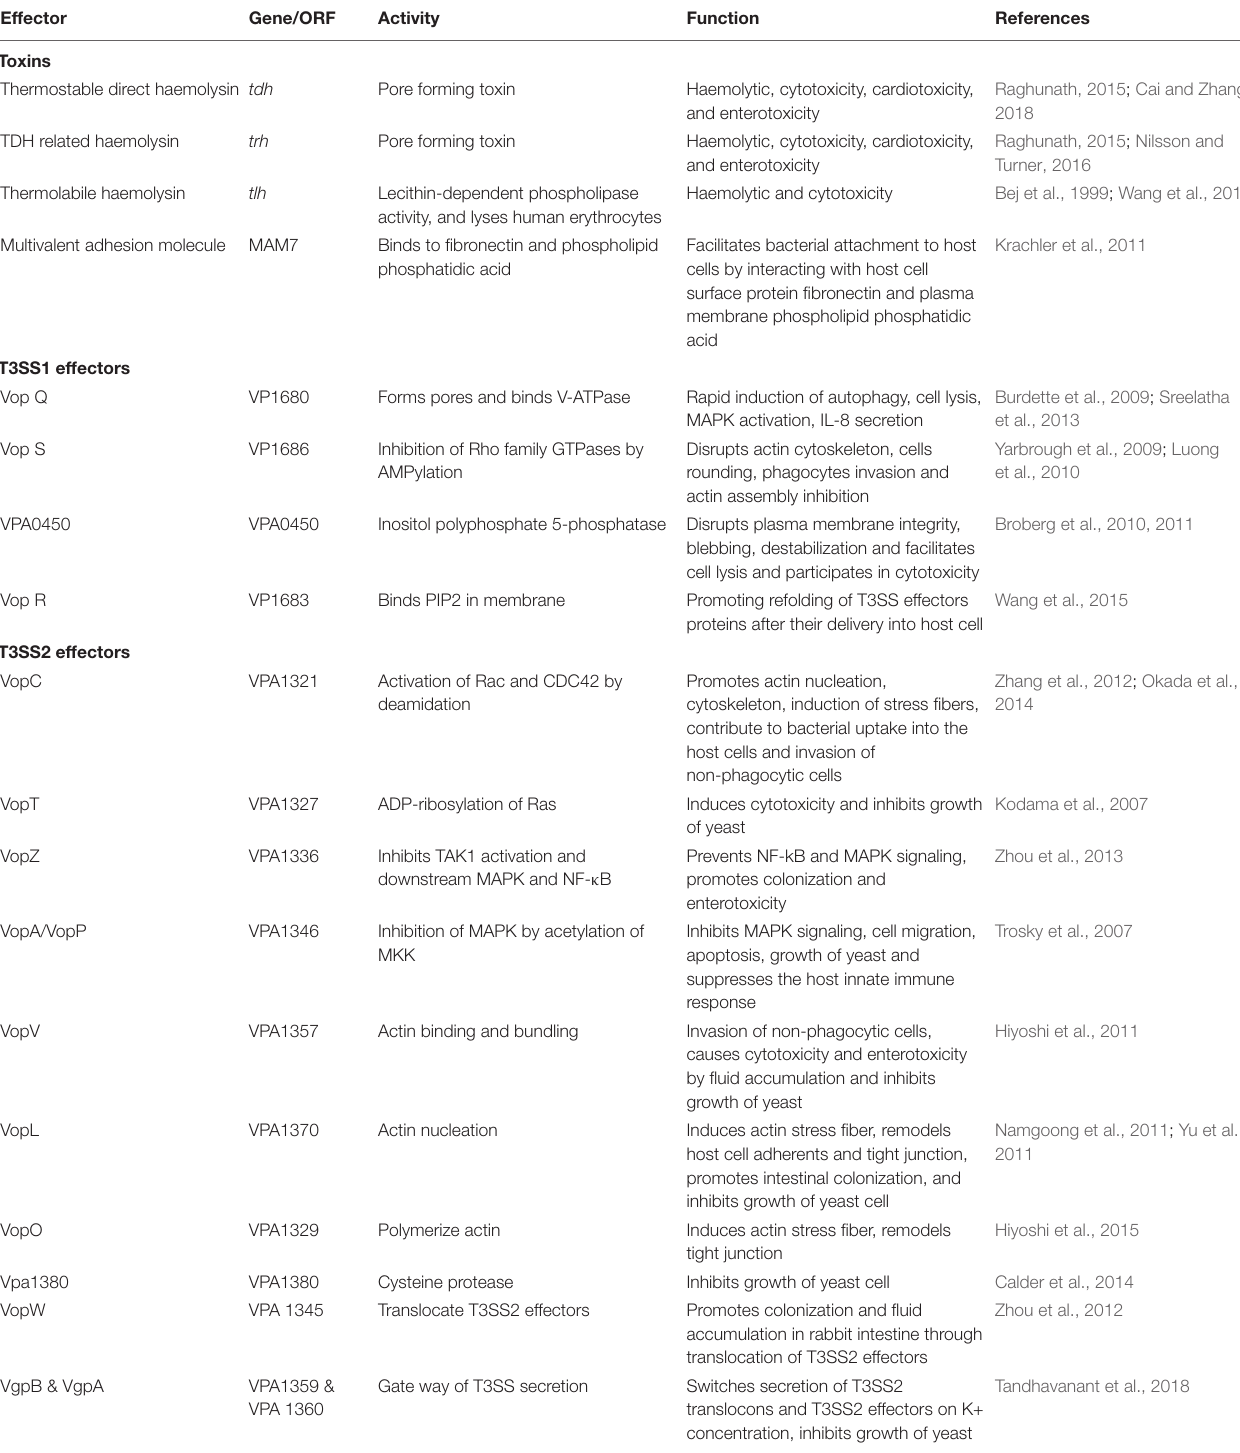
TABLE 1 | Details of known virulence factors of V. parahaemolyticus